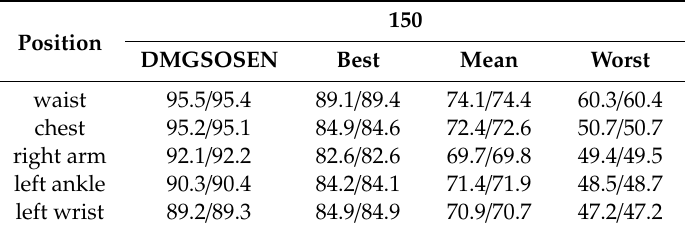
Table 4. Performance of the ensembles for initial pool sizes of 150 (Accuracy / F1%).